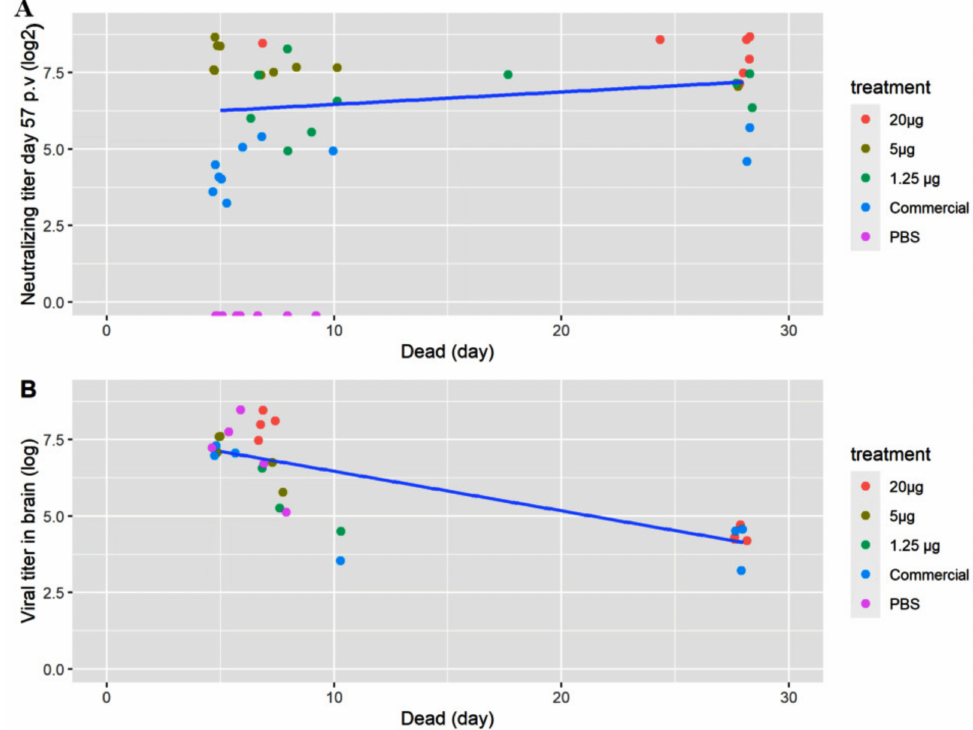
Figure 8. Data on individual fish. ( A ) Neutralizing titer before challenge and ( B ) RGNNV virus titer (TCID50/g) isolated from brain tissue from dead/moribund fish as a function of the day the fish was terminated/diseased. The titers were log transformed to obtain linearity. The colors indicate the treatment (20, 5 or 1.25 µ g VLP, commercial vaccine or